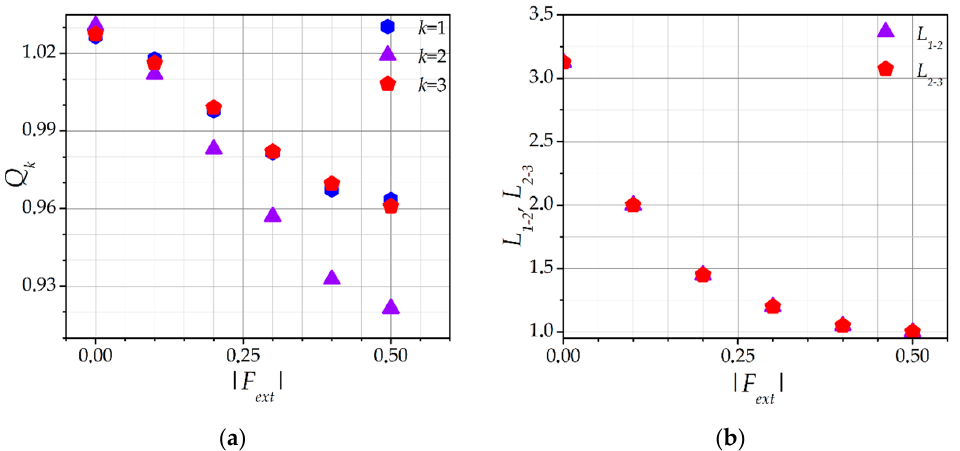
Figure 3. Dependence of the ( a ) self-consistent dust particle charges Q k , and ( b ) equilibrium interparticle distances L 1-2 and L 2-3 between the dust particles in the chain on the external force value F ext . l i = 5, E = 0.